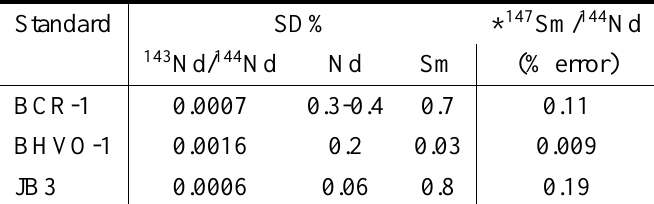
Statistical treatment for the obtained